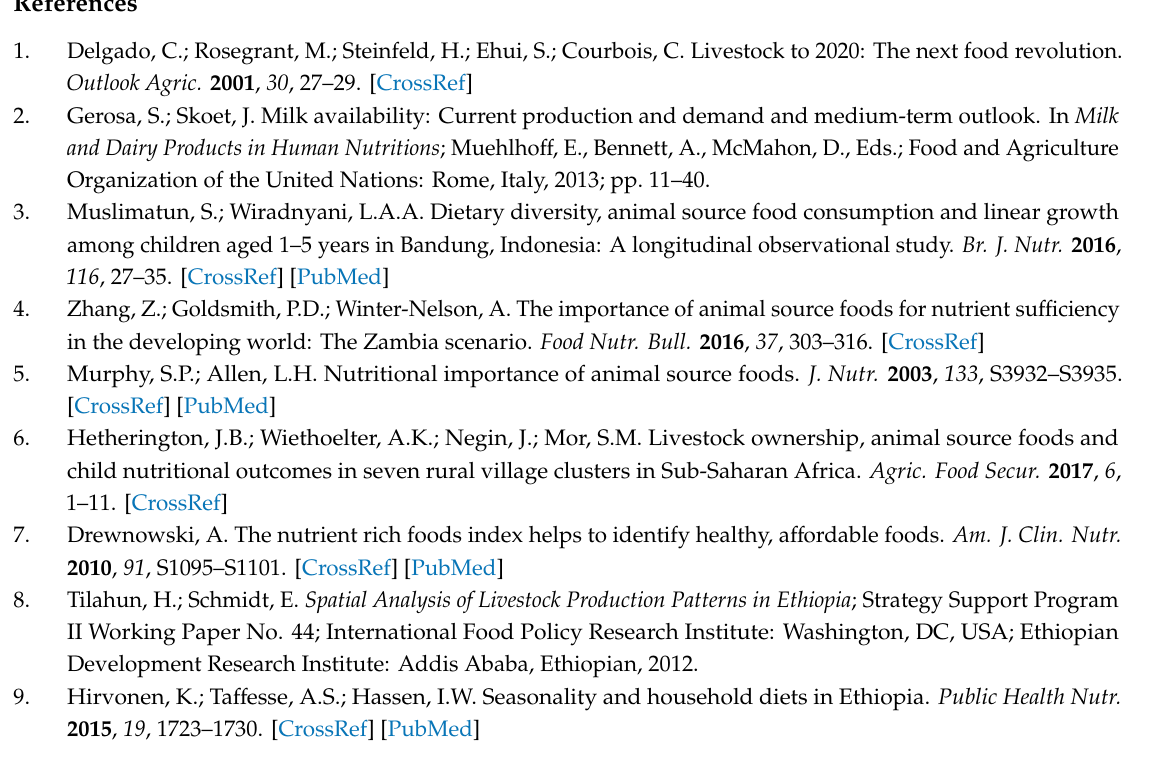
Table S1: Variables names, definitions, and description statistics. Table S2: Results from the extended Probit models accounting for the density of Orthodox believers in an enumeration area. Table S3: Results from the extended Probit models accounting for the density of churches in an enumeration area. Table S4: Results from the extended Heckprobit model accounting for the density of Orthodox believers in an enumeration area. Table S5: Results from the extended Heckprobit model accounting for the density of churches in an enumeration area. Figure S1: Predicted probability to consume milk at household level evaluated at the mean of the other covariates for di ff erent religious groups and interview periods at di ff erent densities of Orthodox believers in an enumeration area. Figure S2: Predicted probability to consume milk at household level evaluated at the mean of the other covariates for di ff erent religious groups and interview periods at di ff erent densities of churches in an enumeration